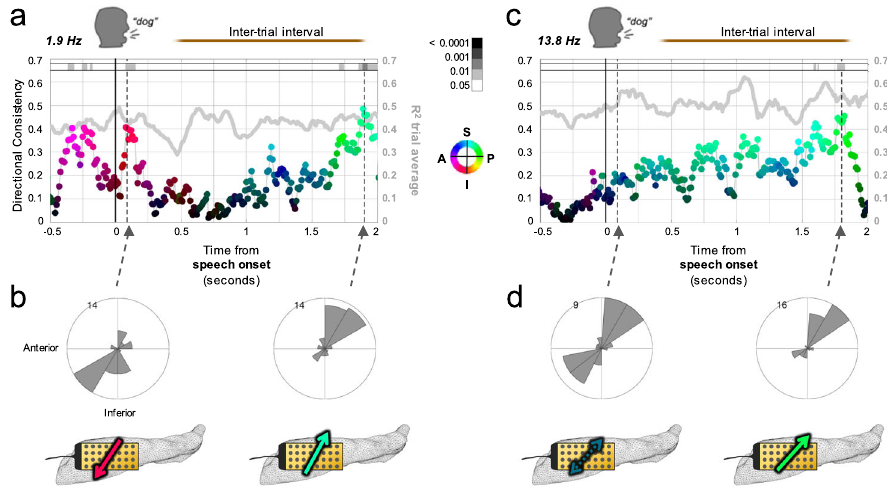
Fig. 4 Alignment of propagation direction during inter-trial intervals. a Directionality consistency (DC; dots) values for the 1.9 Hz peak frequency in Participant 5 ( n = 43 trials) locked to speech onset similar to Fig. 3b (same scale bars and direction color wheel), but extending 2 s into the inter-trial interval (gray line: mean R 2 across trials with separate y -axis at right; shaded region: DC 95% CI for shuf fl ed timepoints). After speech onset, the alignment across trials toward the temporal pole recedes and then reemerges, but aligned more toward the septal pole as the subsequent trial approaches. b Directional distributions for two example timepoints (dotted lines in ( a ), p FDR = 0.0243 and 0.0087, respectively, Rayleigh), illustrating the direction reversal. Bottom, anatomic schematics (left hippocampal microgrid, arrow color same as ( a )) conveying average direction of wave travel over hippocampal surface at those timepoints. c Same as a for the 13.8 Hz frequency, with a low DC around speech onset (though usual quadrants predominate) followed by a steady increase in alignment more toward the septal pole as the subsequent trial approaches. d Directional distributions and schematics for two example timepoints marked by the dotted arrows in ( c ) ( p FDR = 0.4583 and 0.0189, respectively,